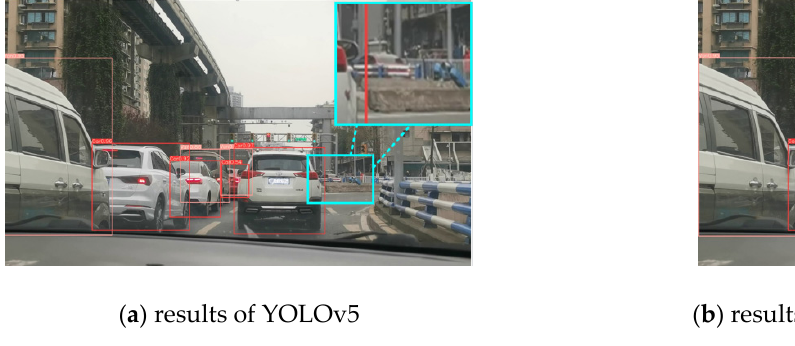
Figure 12. Comparison of detection effects of irrelevant background information occlusion.